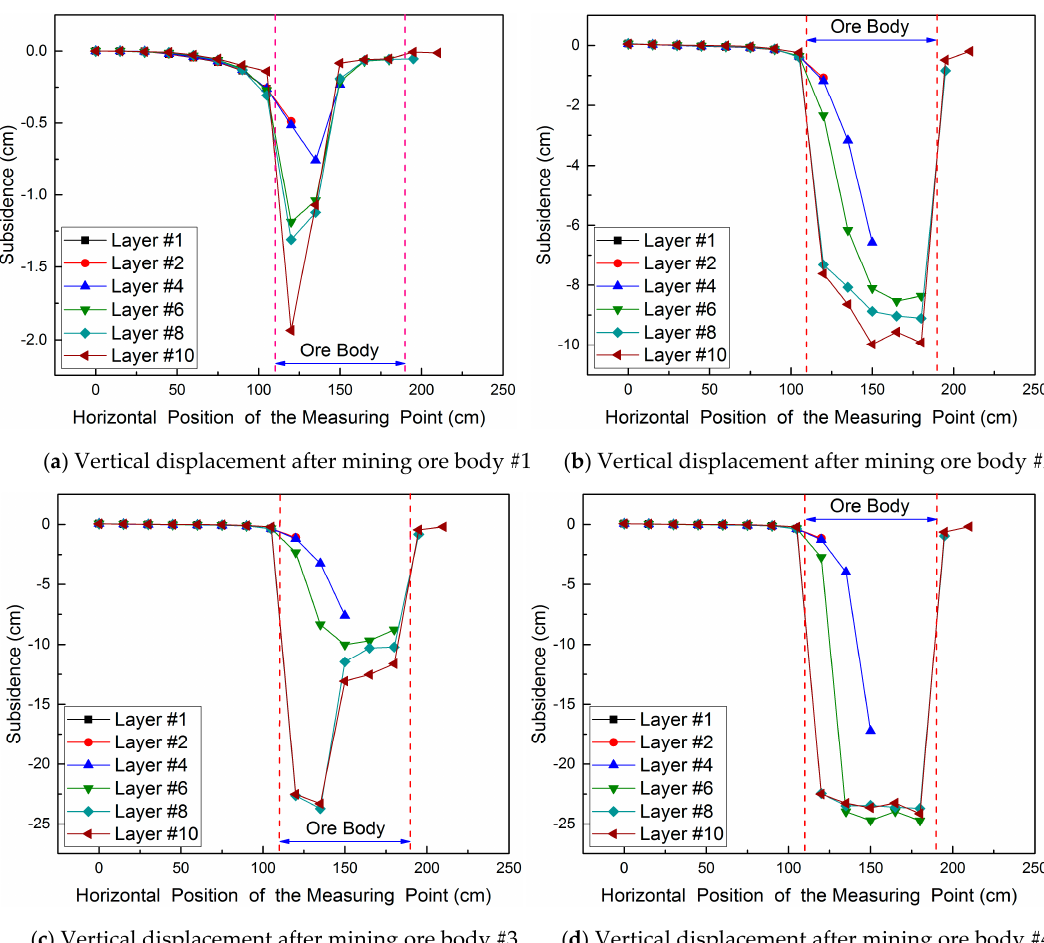
Figure 14. Process of strata movement by numerical simulation